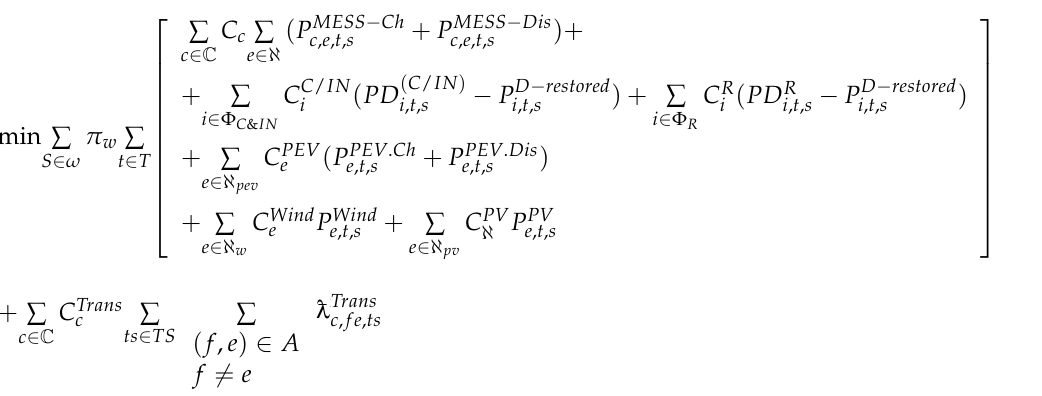
Figure 3. Time ‐ space network (TSN)